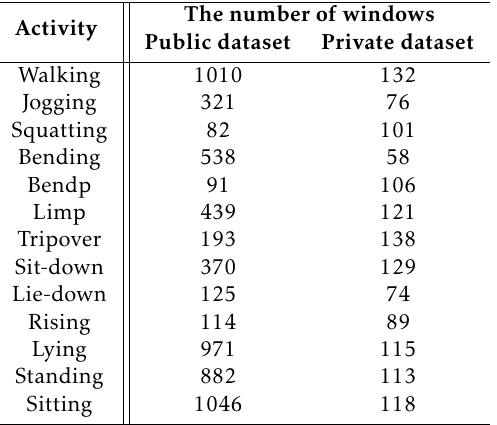
Fig 9. The static window method would divide an activity’s data into sliding windows of the same size over time. Tab 2. Statistics of data windows for each activity on the